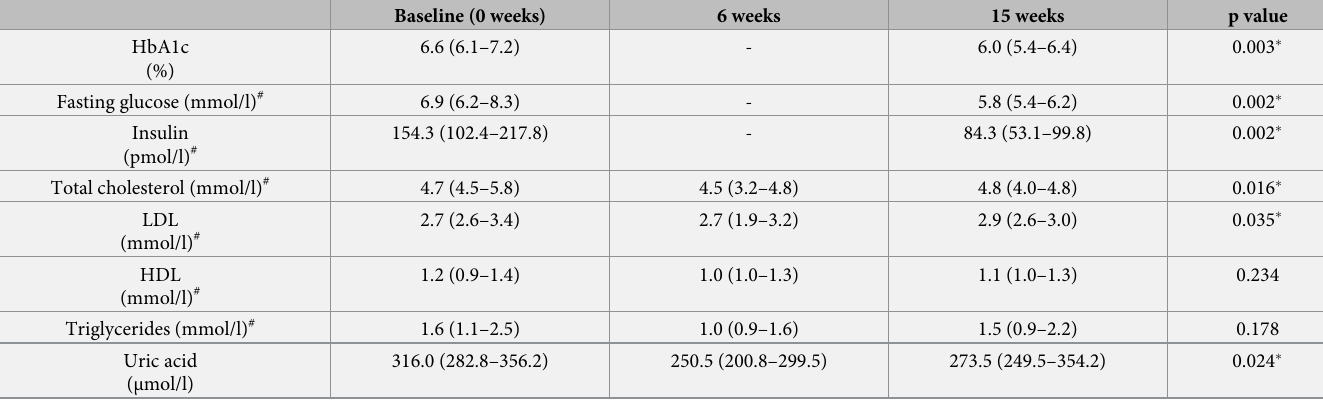
Table 1. Laboratory evaluation of metabolic parameters at different study time